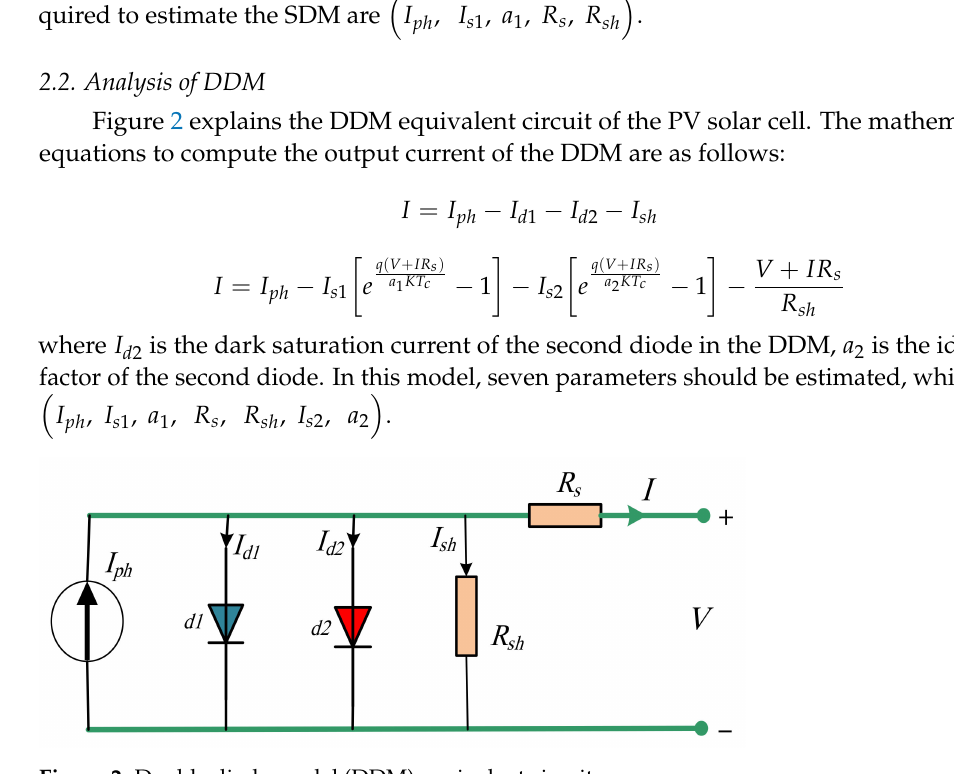
Figure 2. Double diode model (DDM) equivalent